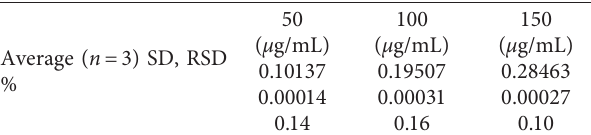
Table 6: LOD and LOQ of SRP.